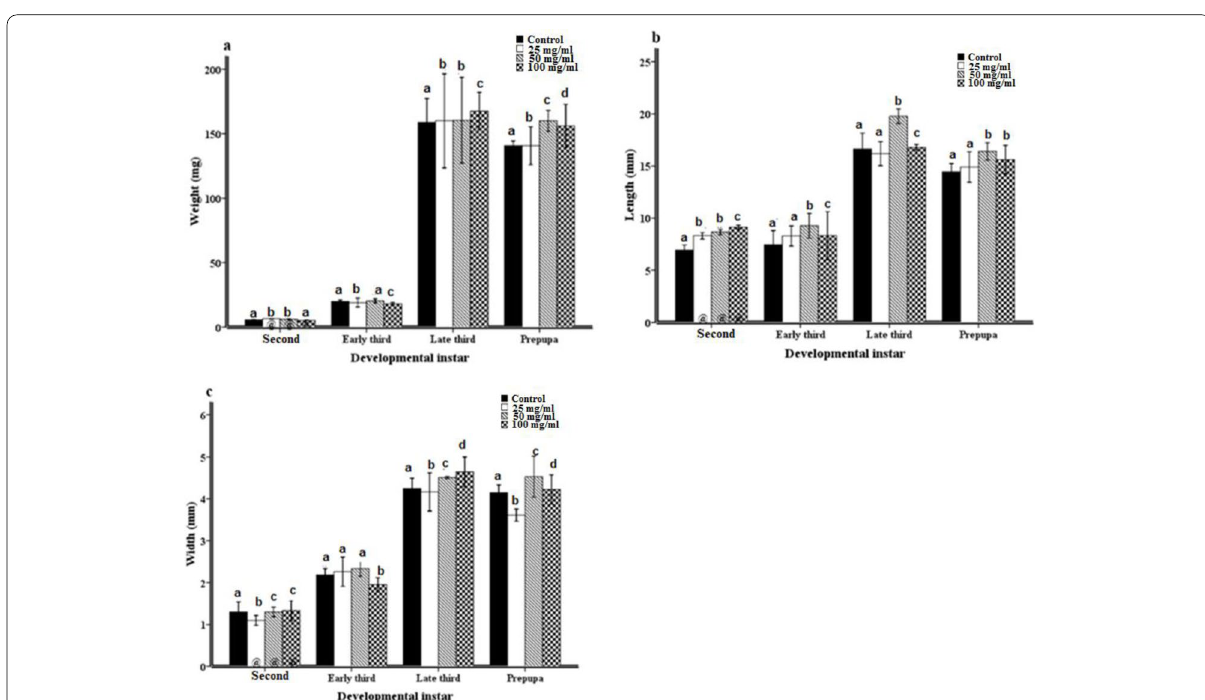
Fig. 1 Impact of different concentrations of clonazepam (25, 50, or 100 mg/ml) on the morphological measurements of larval and prepupal stages of Sarcophaga argyrostoma : a weight (mg), b length (mm), and c width (mm). Data expressed as median and standard deviation (SD). Median values marked with different small letters were significantly different ( p < 0.05) regarding to clonazepam concentration. @ expressed the missing data which simulated using a Monte Carlo concept (Roth and Switzer, 1995)